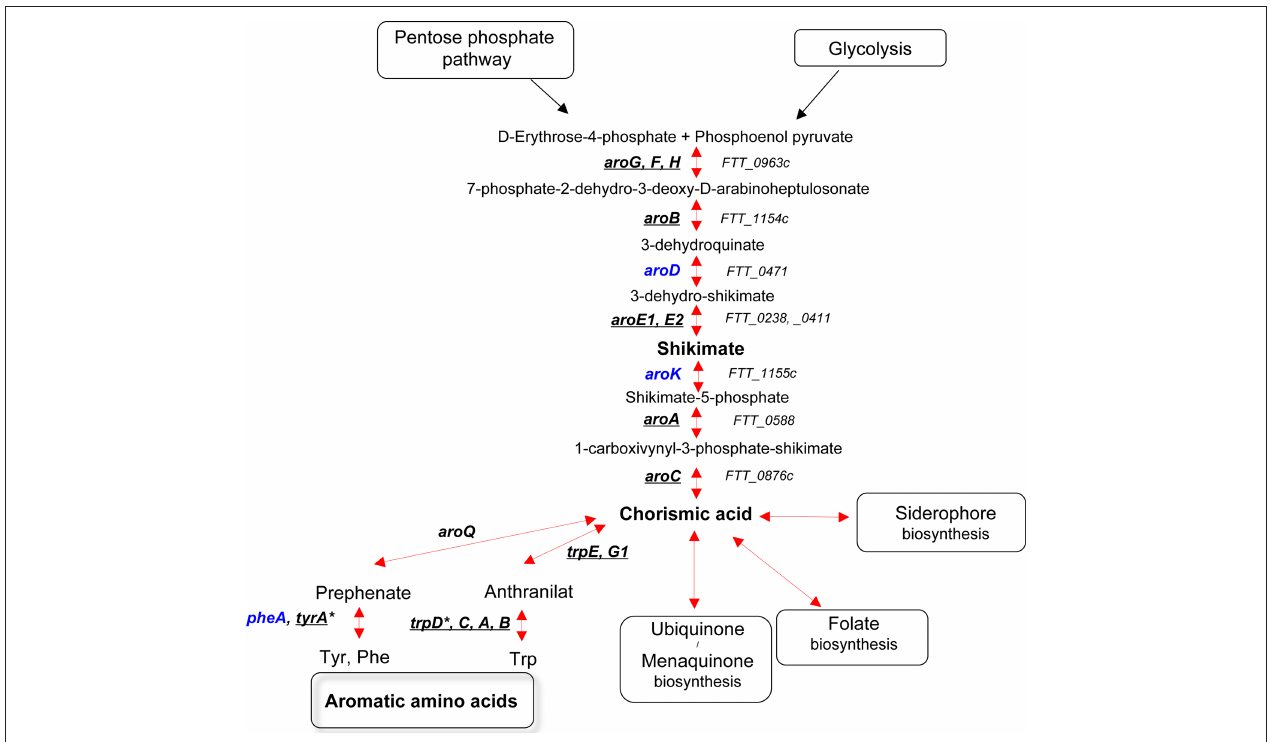
FiguRe 1 | The shikimate pathway. Genes that have been identified in genetic screens ( in vivo or in vitro ) are underlined. Genes that have not been hit in any screen are in blue. TrpD*, the gene is absent in the Schu S4 and LVS strains but present in the subsp. novicida (FTA_2078). TyrA*, the gene is absent in the Schu S4 strain but present in both LVS (FTL_048) and subsp. novicida (FTN_0055).